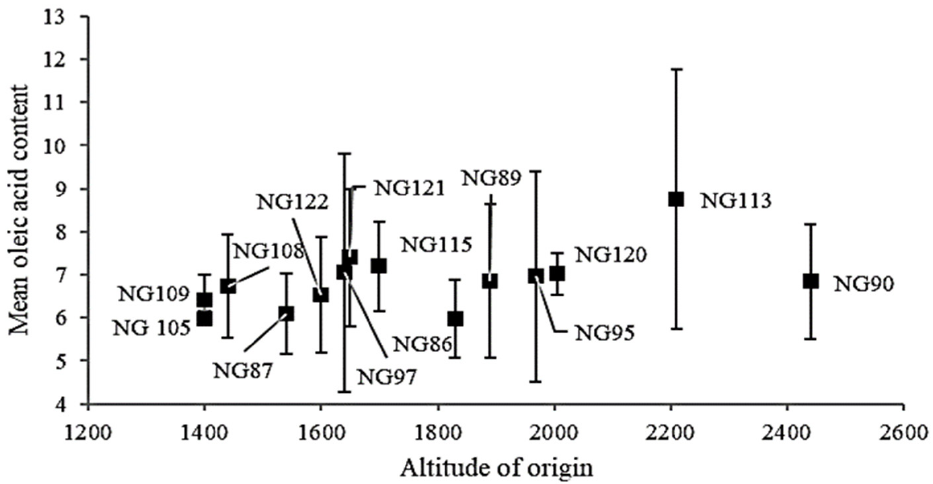
Figure 2. Variation of oleic acid content against altitude of genotype origin.